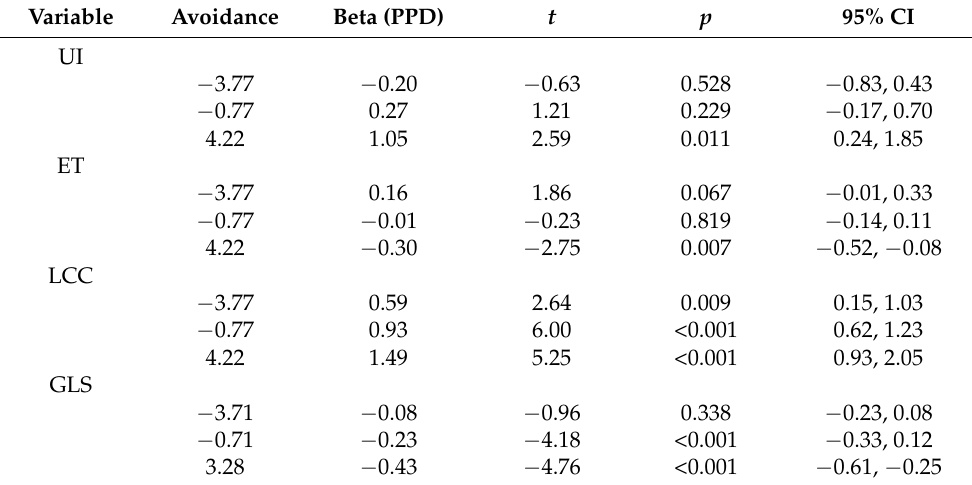
Table 3. Conditional effects of PPD on maternal perceptions about newborn behavior and confidence in caring for the baby.